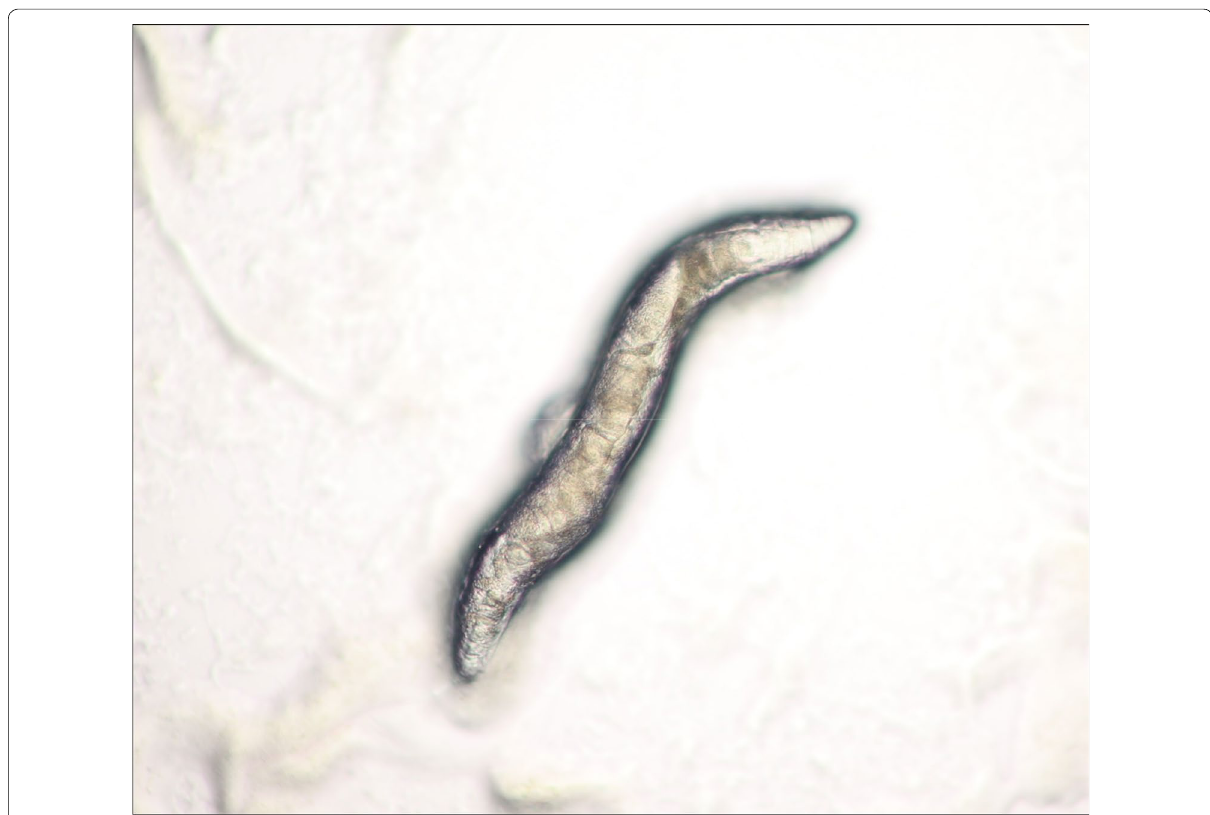
Fig. 2 Caenorhabditis elegans